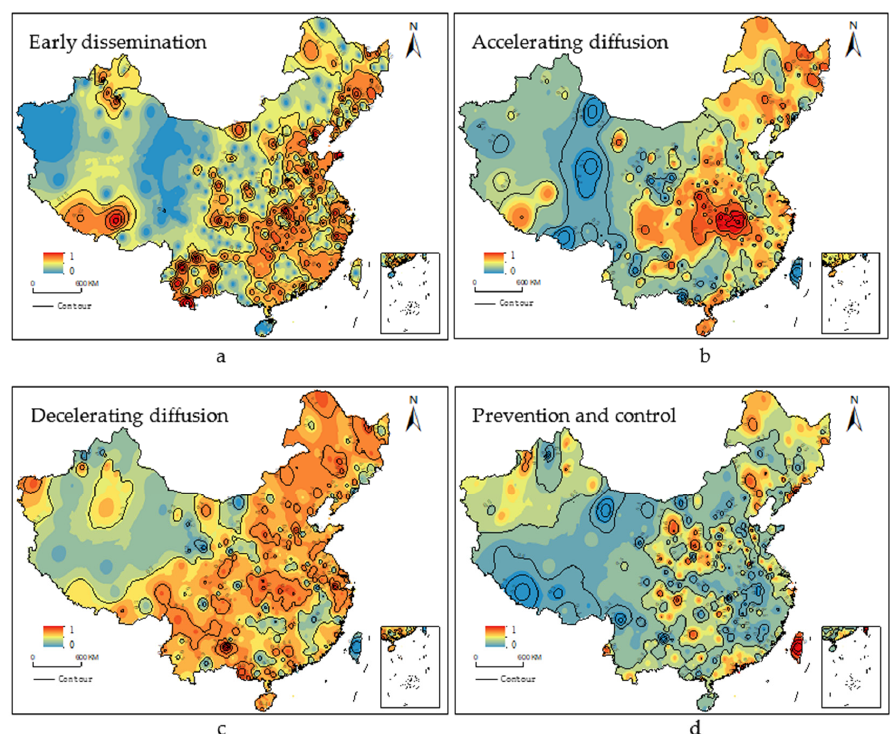
Figure 7. Spatial distribution of environmental risk perception during COVID-19 epidemic.